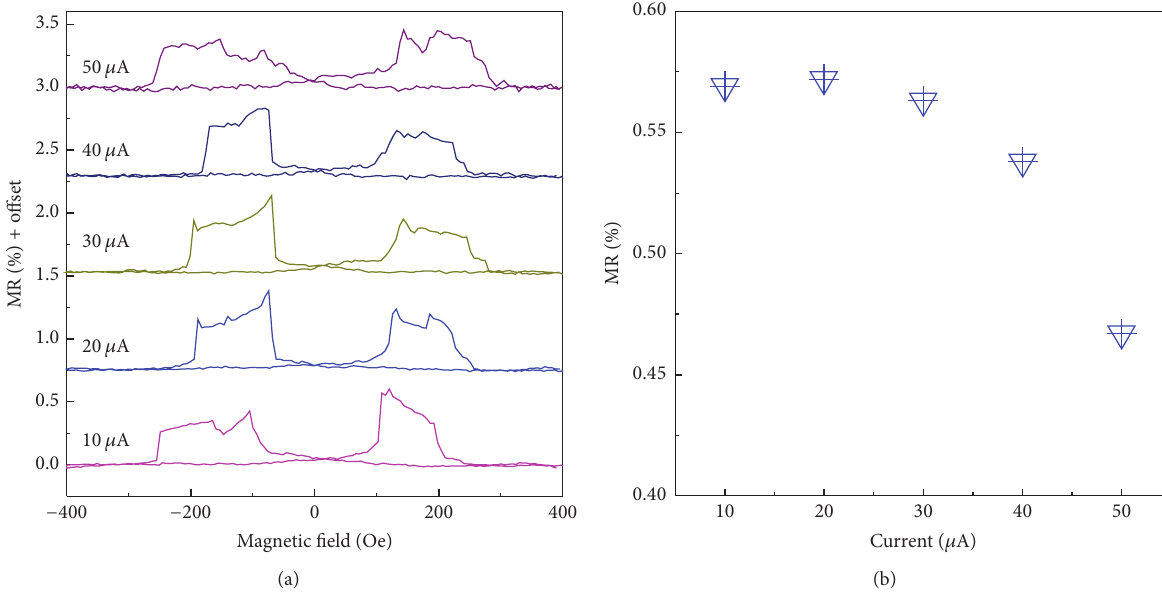
Figure 4: (a) Magnetoresistance curve at various bias currents. (b) MR ratio as a function of bias